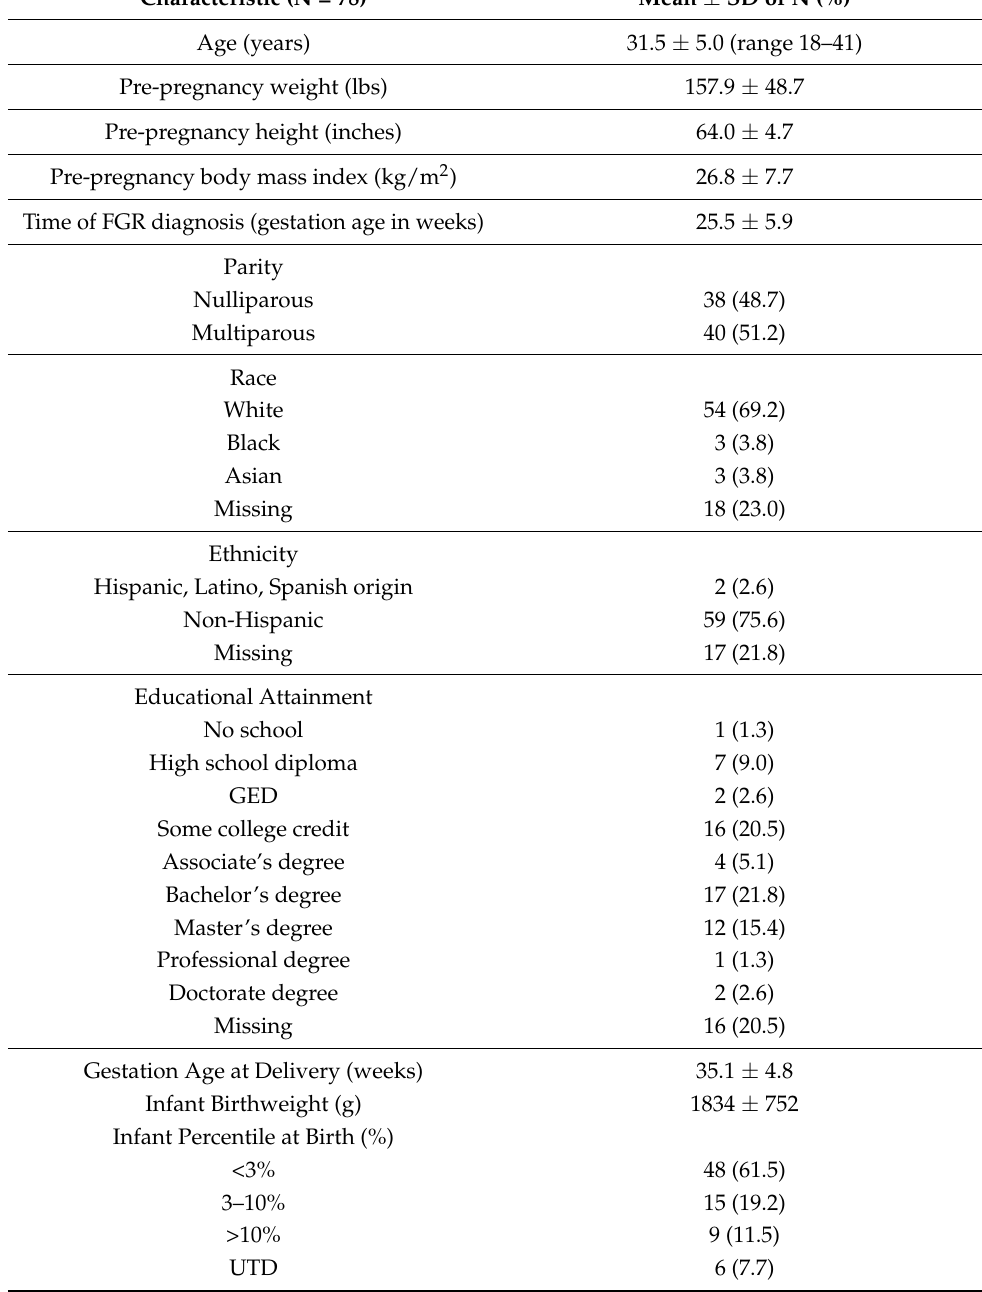
Table 1. Demographic